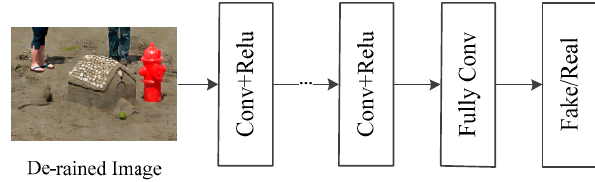
Figure 5. Architecture of discriminative network.